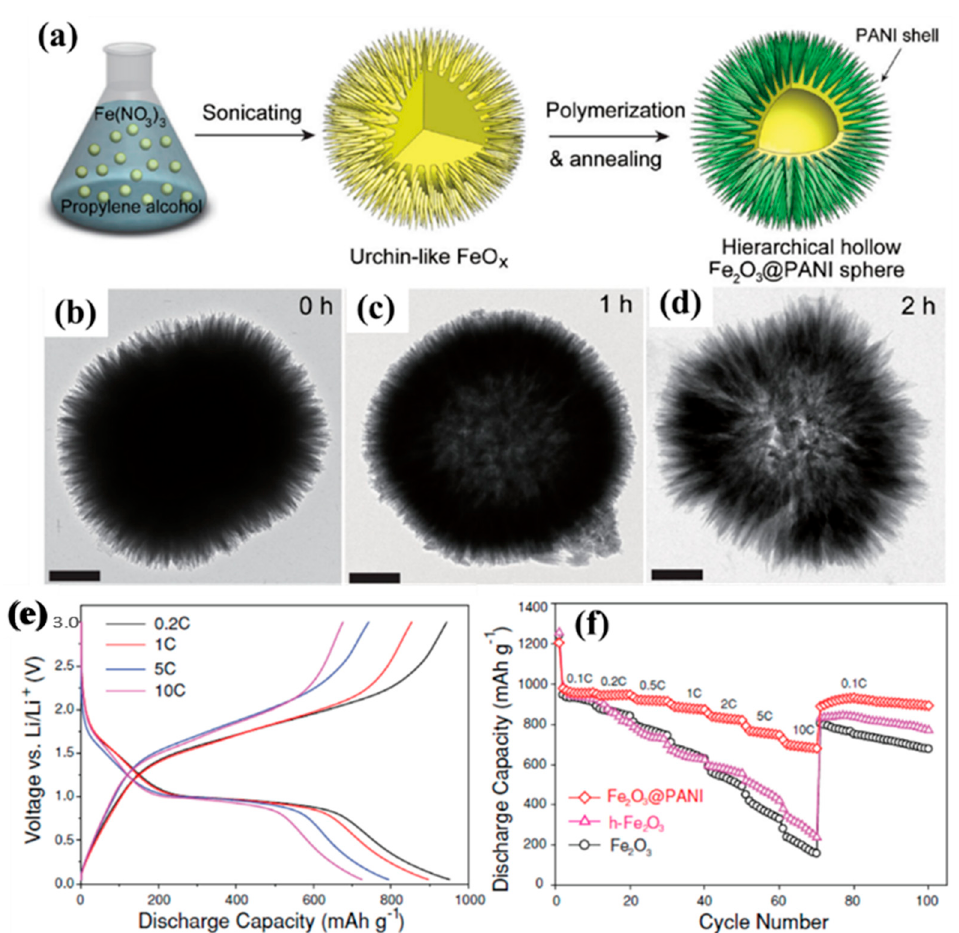
Figure 9. ( a ) Schematic demonstration of the procedure for synthesis of hierarchical Fe 2 O 3 /PANi. ( b – d ) TEM images of the particles were obtained with various reaction times for PANi polymerization (scale bar is 200 nm). ( e , f ) Rate performance of Fe 2 O 3 /PANi electrode at rates 0.1 C–10 C. Reproduced from Ref [42] with permission from Wiley.